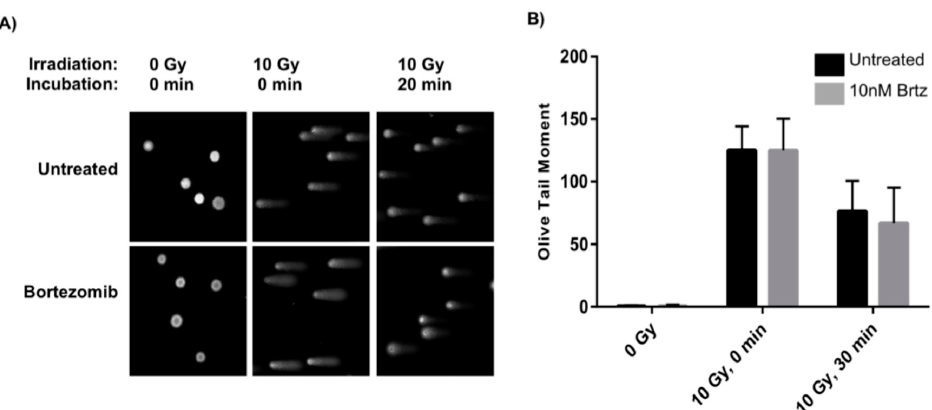
Figure 2. Initial DNA damage response is not inhibited by 26S proteasome inhibition. ( A ) SW620 cells were untreated or treated with 10 nM bortezomib, incubated for 24 h, mock-irradiated (0 Gy) or irradiated with 10 Gy, and either immediately placed on ice and prepared for comet assays or incubated for 20 min at room temperature followed by 10 min on ice and prepared for comet assays; ( B ) Olive tail moments for non-irradiated, irradiated with 10 Gy with no incubation, and irradiated with 10 Gy with incubation were compared for untreated (black) and bortezomib treated (gray) cells. Data for irradiated cells are the average of two independent experiments with error bars denoting standard deviation.